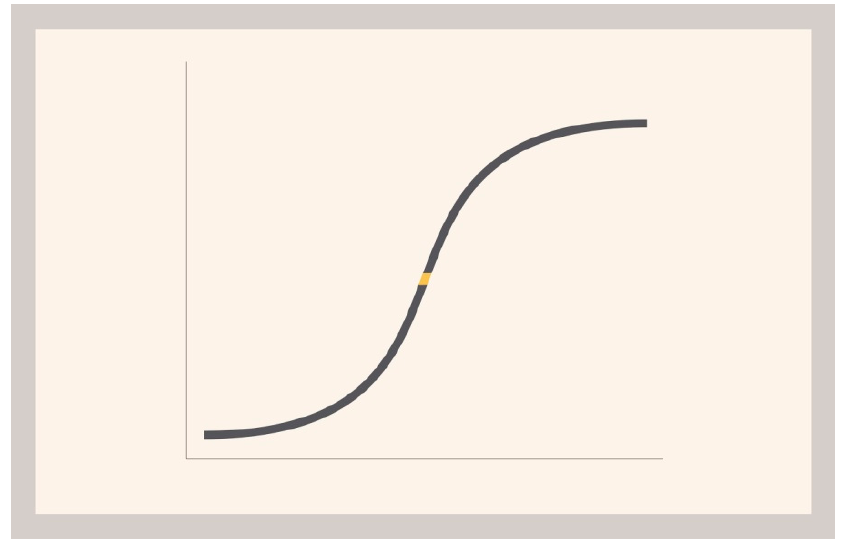
Figure 2. The sigmoidal pattern of population growth in a limited environment, as demonstrated in Raymond Pearl’s classic experiment with fruit flies in a bottle.